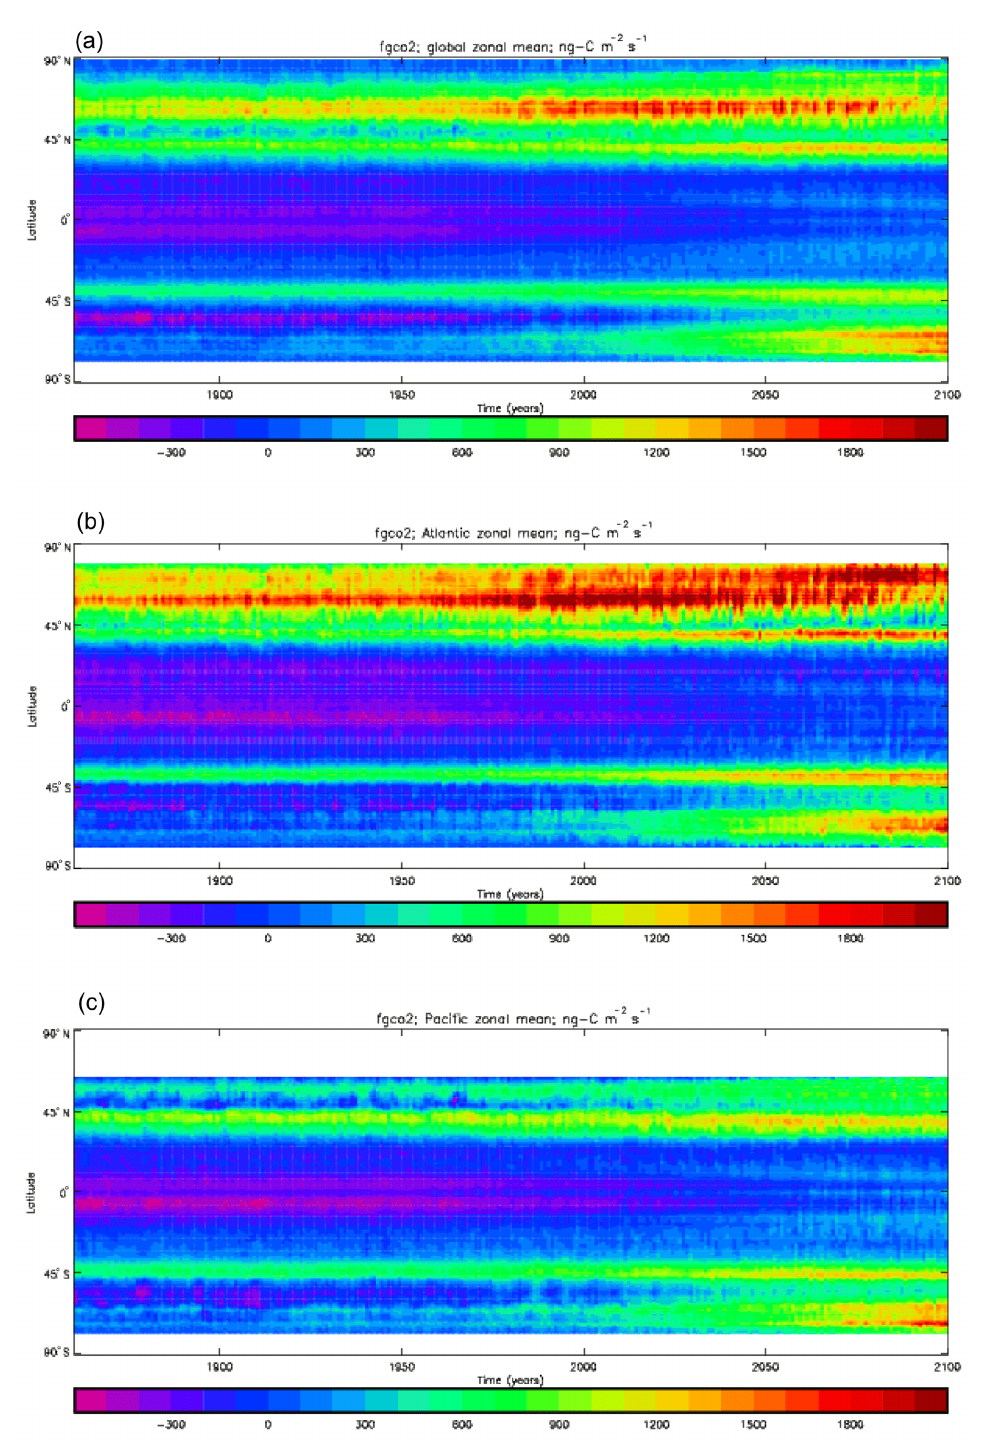
Figure 41. Change in the annual mean total air-to-sea CO 2 flux (ngCm − 2 s − 1 ) during model years 1860 to 2099 in the historical and RCP8.5 simulations. (a) Global zonal mean; (b) Atlantic Ocean basin zonal mean; (c) Pacific Ocean basin zonal